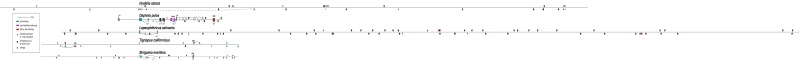
Crustacea and Myriapoda lack motif conservation and exhibit loss of pb and/or Hox3 orthologs.